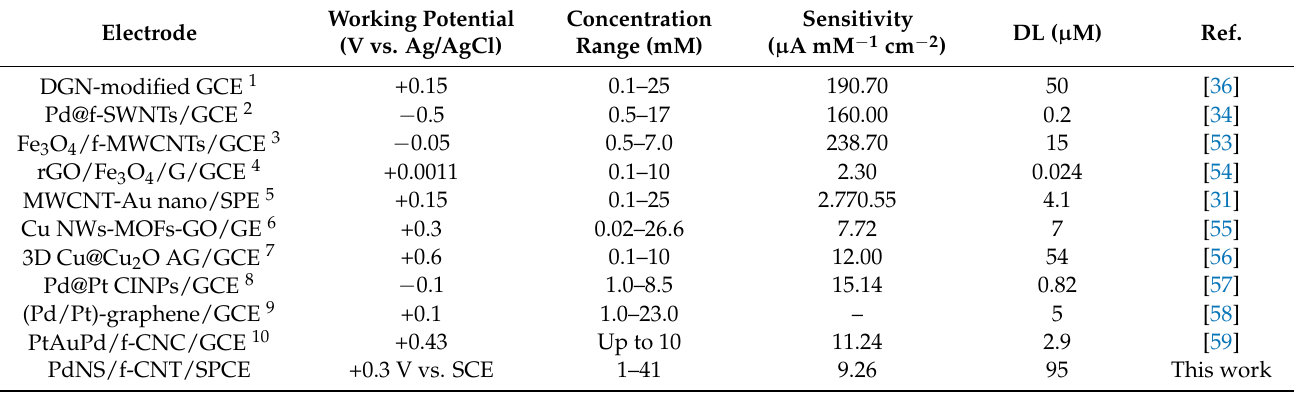
Table 2. Summary of the analytical features of the developed PdNS/f-CNT as non-enzymatic electrochemical glucose sensors for glucose sensing in neutral environments (PBS, pH 7.4).